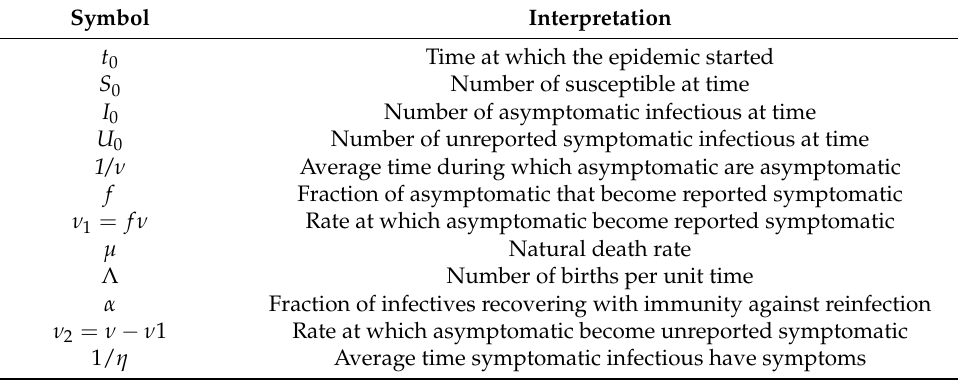
Table 2. Parameters of the model using the added compartment summarizing the reported and unreported